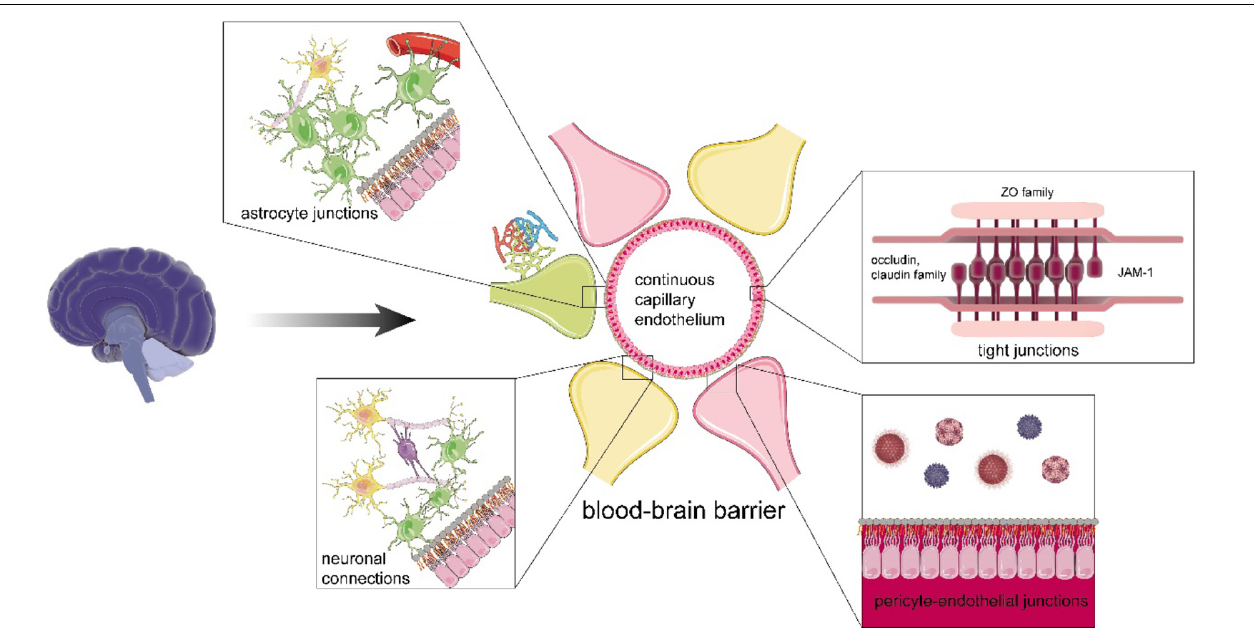
FIGURE 3 | The functional structure of the blood-brain barrier (BBB). The BBB includes continuous capillary endothelium with tight junction (TJ), adherens junctions and gap junctions, pericyte-endothelial junctions, astrocyte junctions, neural connections, intact basement membrane, and glial membrane. The TJ is abundant in TJ proteins. For instance, claudin and scaffolding protein, such as zonula occludens family, form the backbone of TJ, occludin helps maintain the integrity and stability of TJ, and junctional adhesion molecule A mediates cell adhesion to restrict epithelial permeability. In terms of astrocytes, they can strengthen the BBB by junctions with ECs, communicate with myelinated nerve fiber and synapses, and support them. For neurons, their connections are enhanced by glial cells, such as oligodendrocytes, which can assist efficient jump transmission of bioelectrical signals and maintain the normal function of neurons.